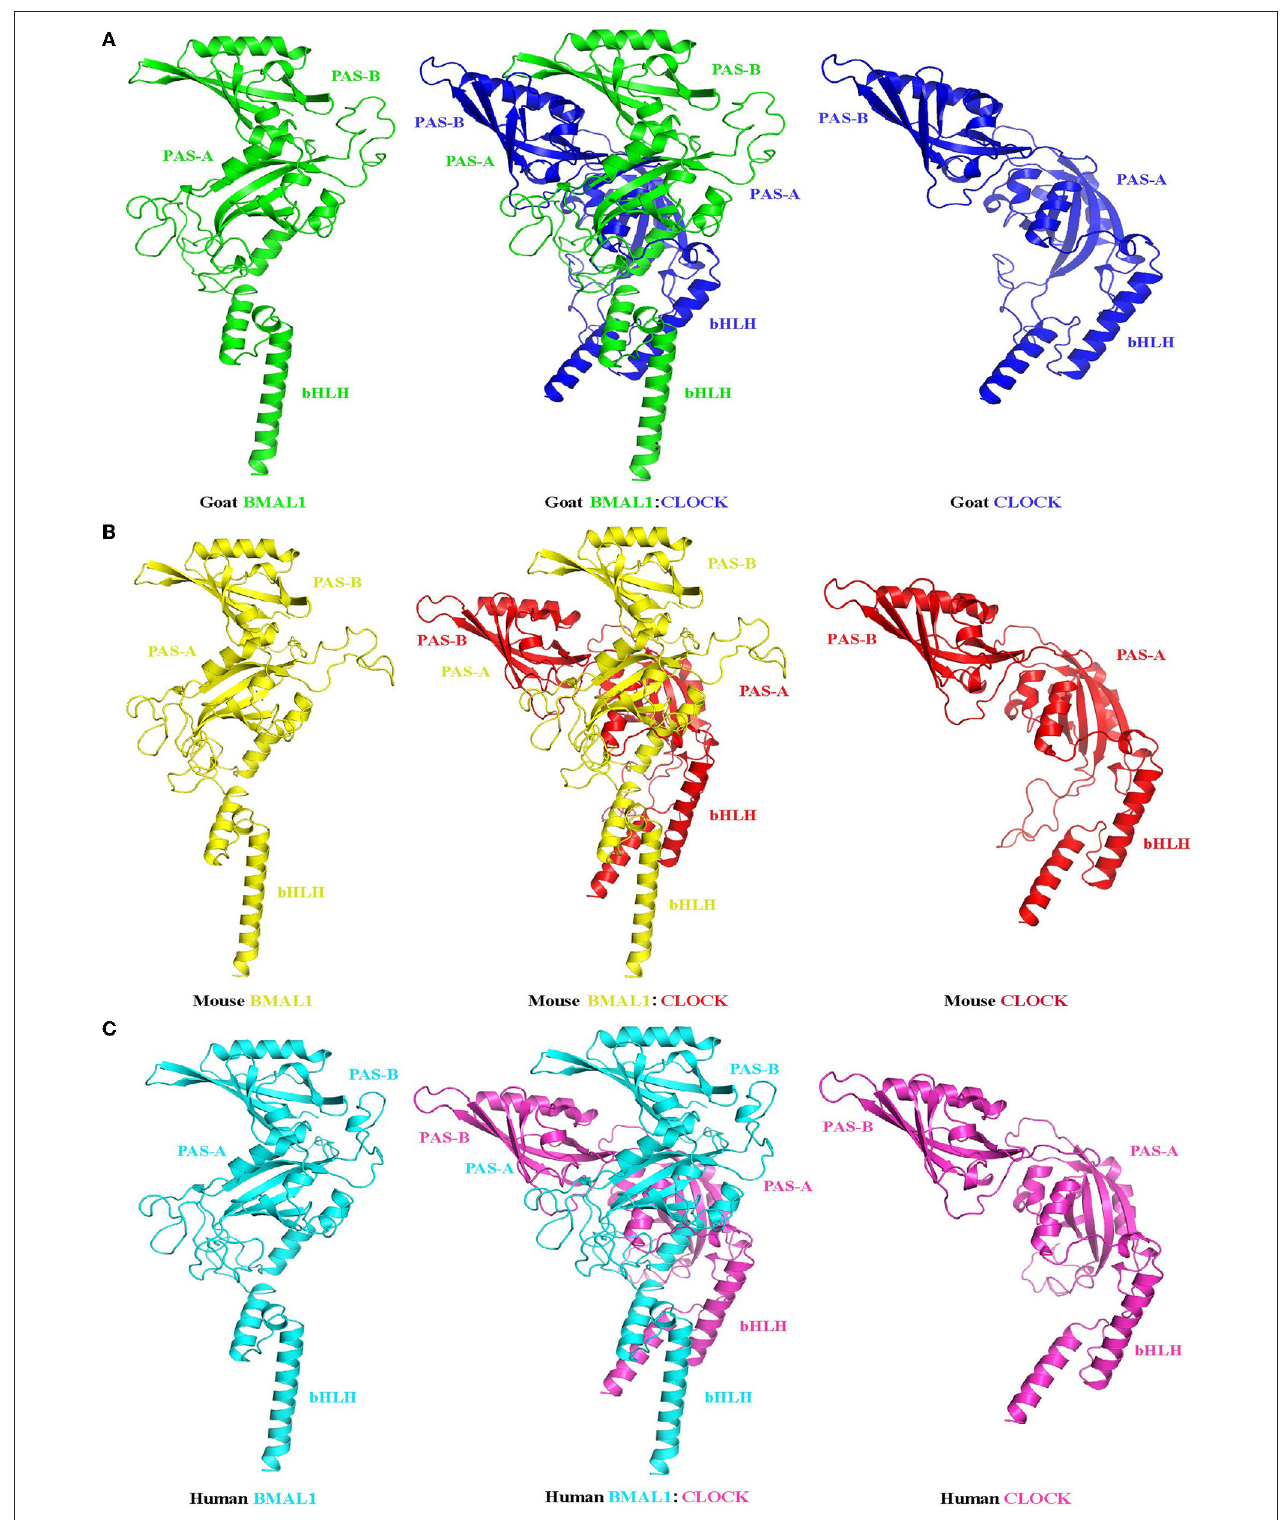
FIGURE 6 | Prediction of the tertiary structure of the circadian clock core transcription factors BMAL1 and CLOCK and their heterodimers in goats (A) , mice (B) , and humans (C) . Ribbon diagram of BMAL1: CLOCK heterodimer (center). Each individual domain is labeled. The BMAL1 (left) and CLOCK (right) subunits are also shown separately to illustrate their different spatial domain arrangements. PAS-A: Per-Arnt-Sim A domain; PAS-B: Per-Arnt-Sim B domain; bHLH: basic helix-loop-helix domain.